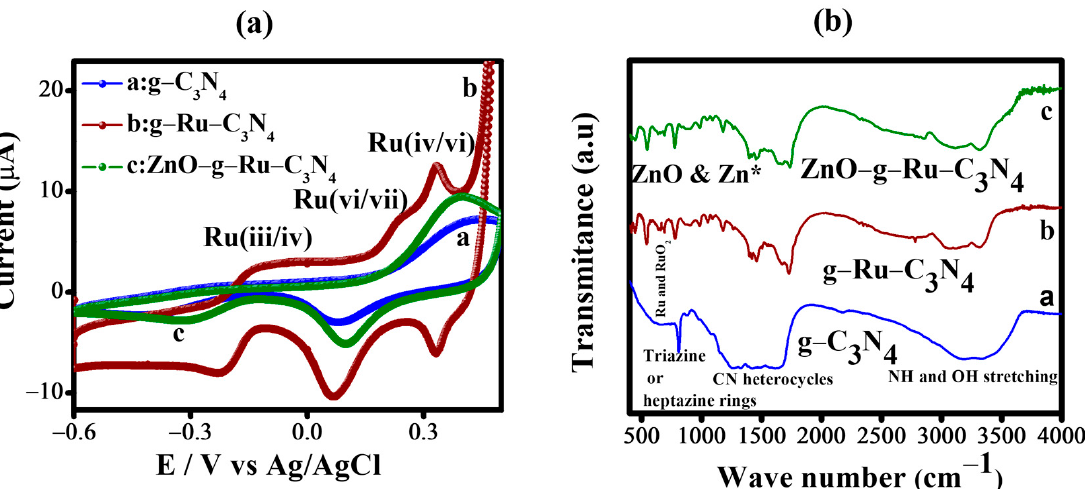
Figure 1. ( a ) CV behaviors of AuE-g-C 3 N 4 (curve a), AuE-g-Ru-C 3 N 4 (curve b) and AuE-ZnO-g-Ru- C 3 N 4 (curve c) modified electrode in the presence of 1 M NaOH in DD water at a scan rate 50 mV s − 1 . ( b ) FT-IR spectra of g-C 3 N 4 (curve a), g-Ru-C 3 N 4 (curve b) and ZnO-g-Ru-C 3 N 4 (curve c). * Skeletal vibration with carbon nitride.